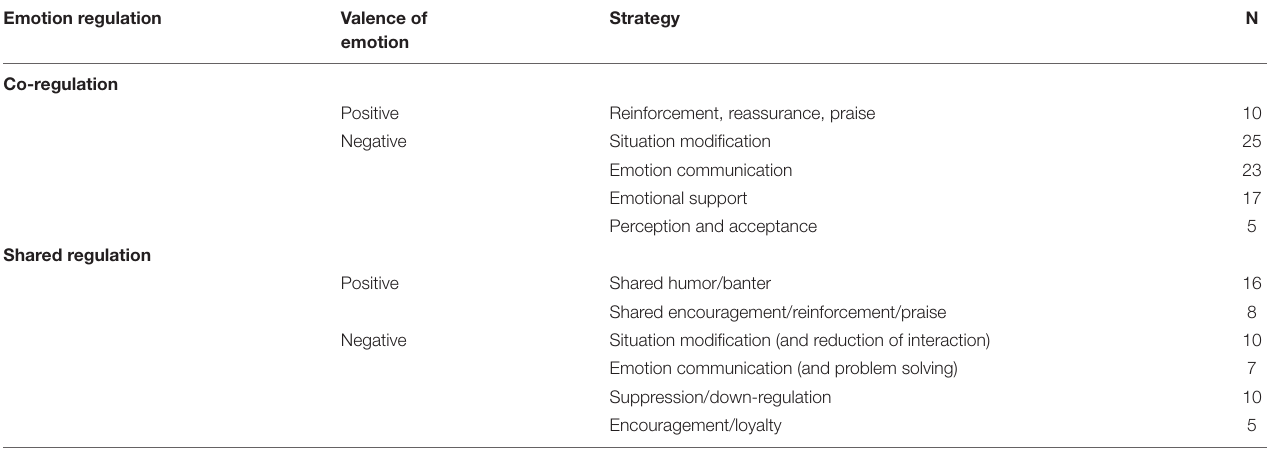
TABLE 4 | Co- and shared emotion regulation strategies and absolute number of team